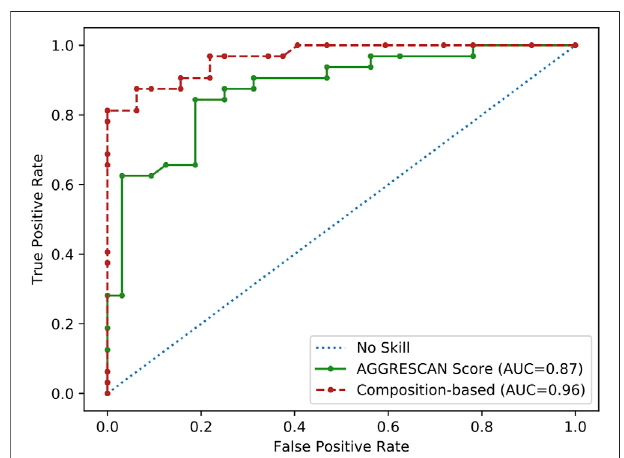
FIGURE 2 | ROC curve analysis of the aggregation propensity as a predictorofPrLDsassemblypropensity.Performanceofaggregationpropensity andcompositionpredictionsofheat-inducedPrLDs invivo recruitmenttoSGas described by Ross and coworkers (Boncella et al.,